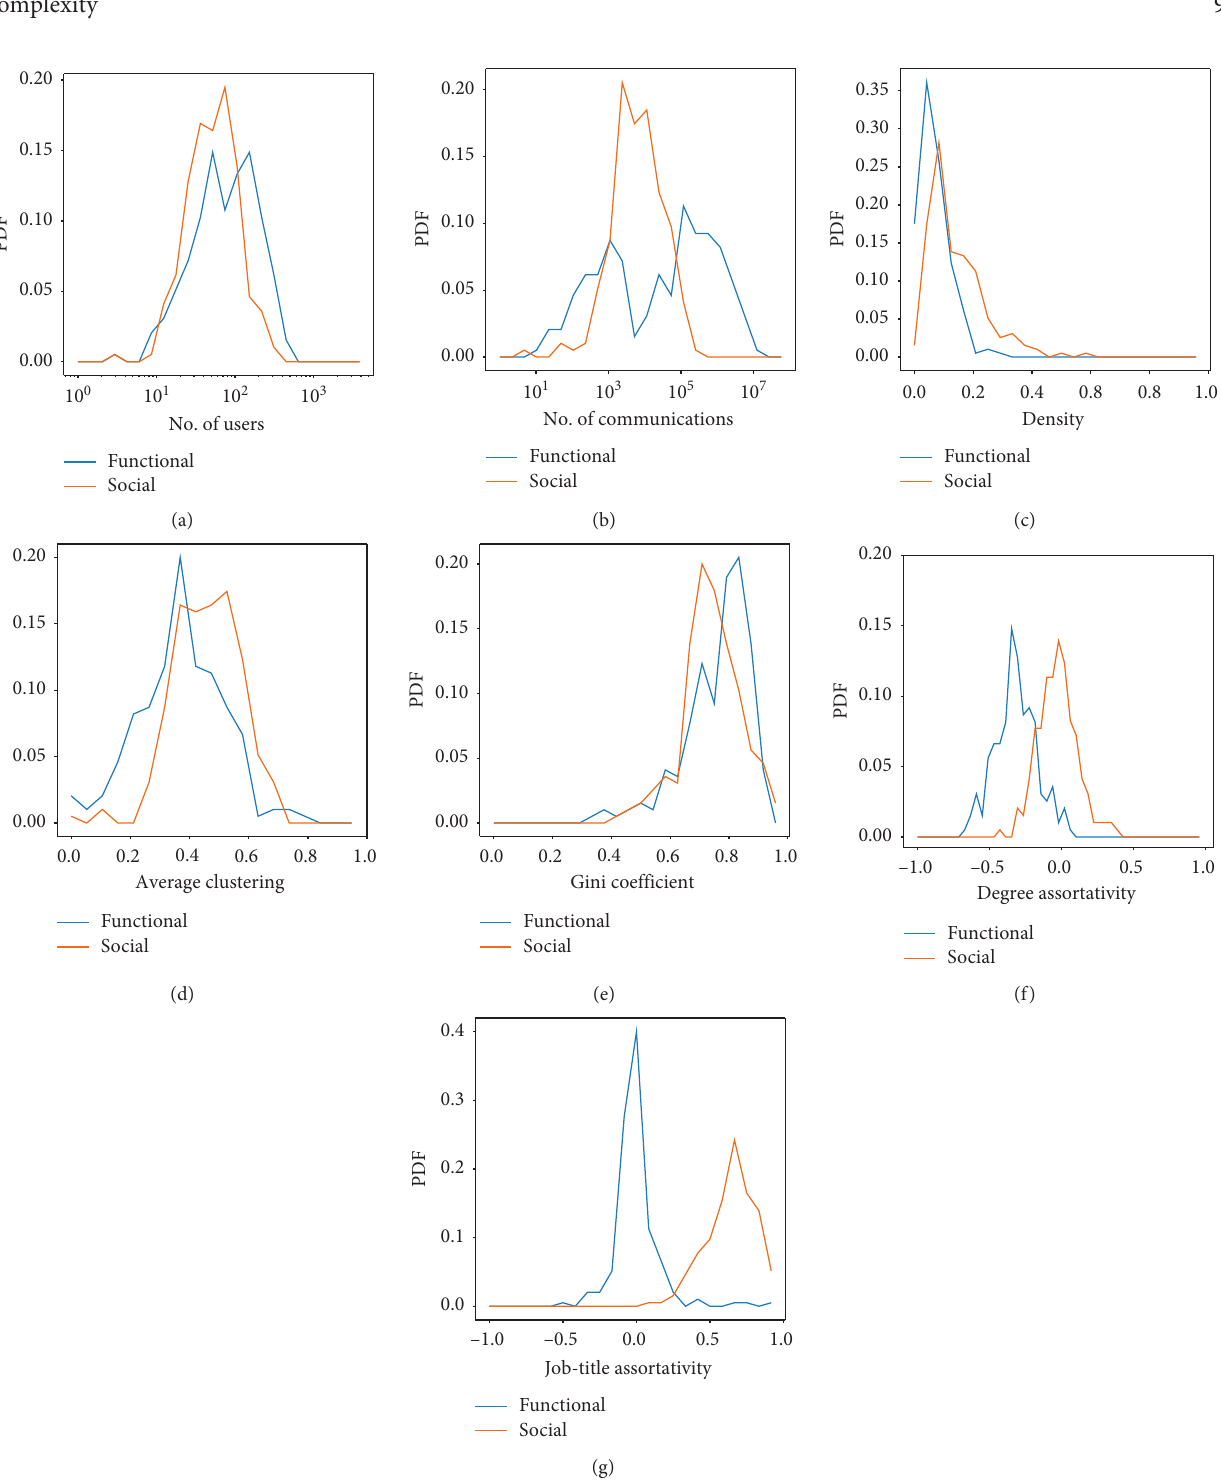
Figure 7: Properties of functional (blue) and social (orange) communication networks for all enterprises. (a) Distributions of a number of users. (b) Distributions of a number of communications. (c) Distribution network density. (d) Distribution of average clustering. (e) Distribution of Gini coefficients of the degree distributions. (f) Distribution of degree assortativity coefficients. Negative values indicate asymmetrical interactions. (g) Distribution of job-title assortativity coefficients. Positive values indicate segregated interactions. A set of statistical tests comparing these distributions is shown in Table